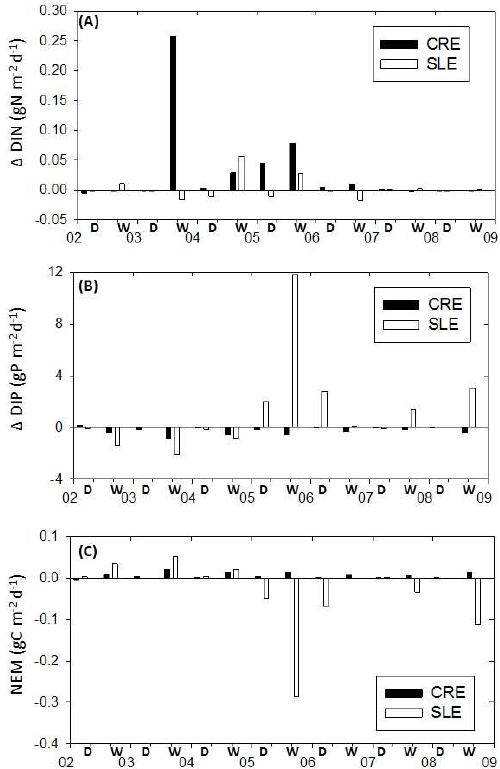
Fig. 7. Comparative seasonal time series of internal CNP source/sink processing for CRE and SLE. CRE (filled) and SLE (open) bars are paired seasonally with the first pair of each year representing the dry season. (A) 1 DIN (g Nm − 2 d − 1 ) ; (B) 1 DIP (g Pm − 2 d − 1 ) ; (C) NEM (g Cm − 2 d − 1 ) . Fig. 8. Scatter plots from seasonal DIN and DIP budgets for CRE